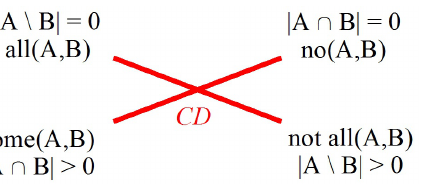
Figure 2. Degenerate Aristotelian square for the Aristotelian quantifiers, relative to FOL